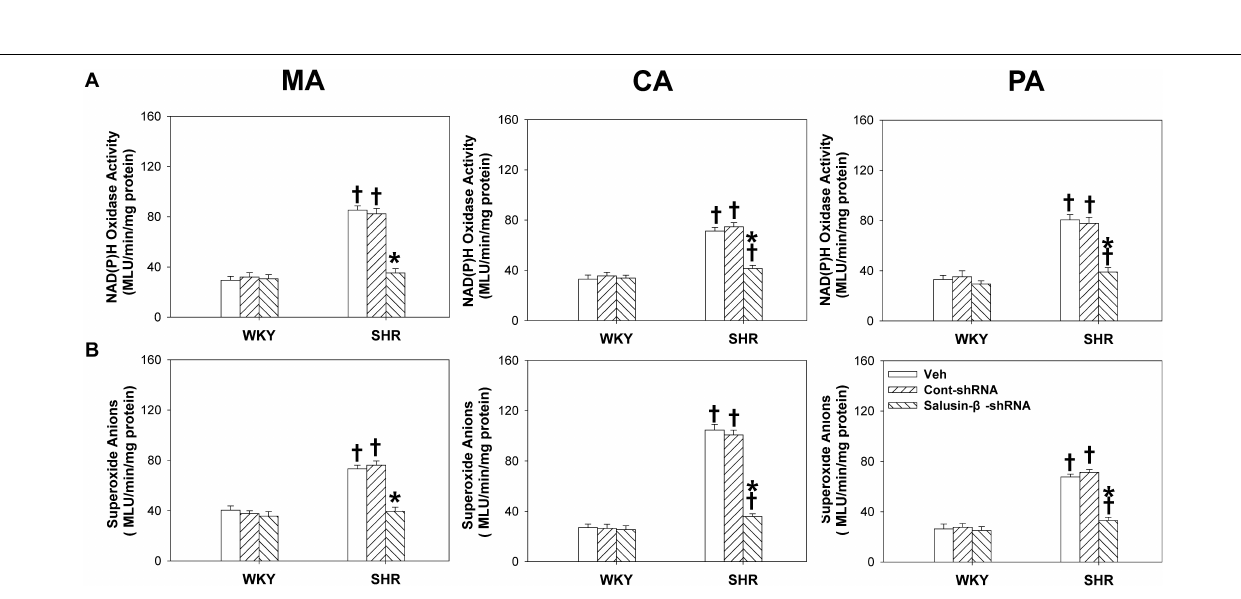
Frontiers in Physiology |